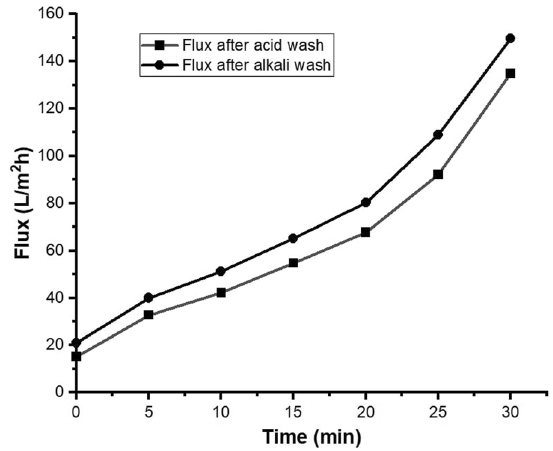
Fig. 11 Effect of chemical cleaning duration on flux of RO membrane modified by treatment with hypo for 900 min